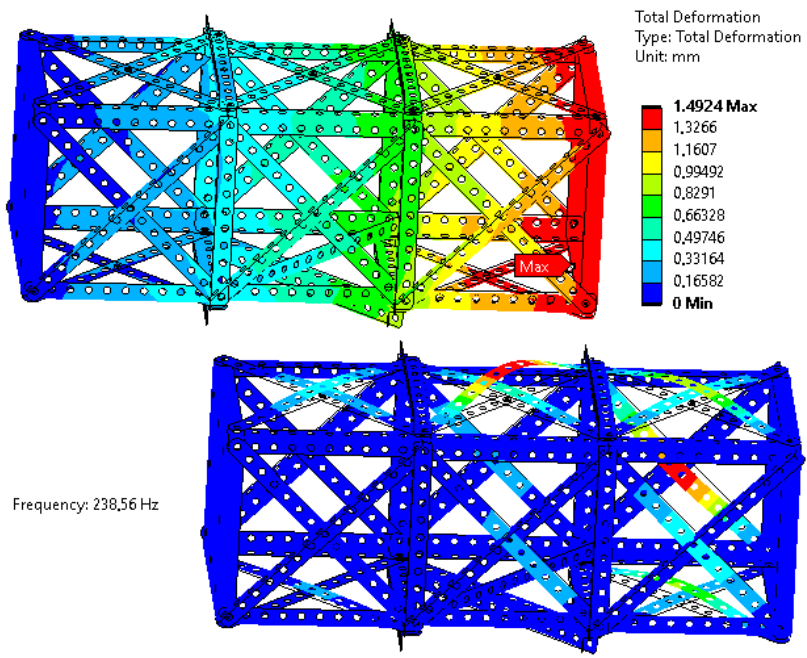
Figure 13. Results for Model 2 with displacement and 1st natural